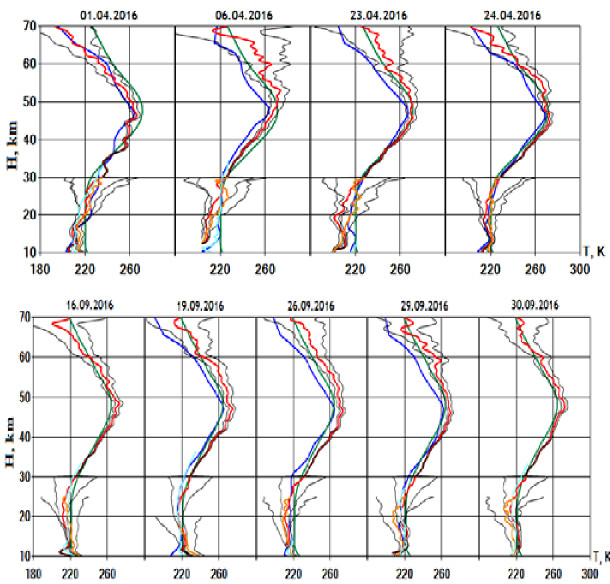
Fig. 4. Vertical distribution of temperature in some nights of February 2016.